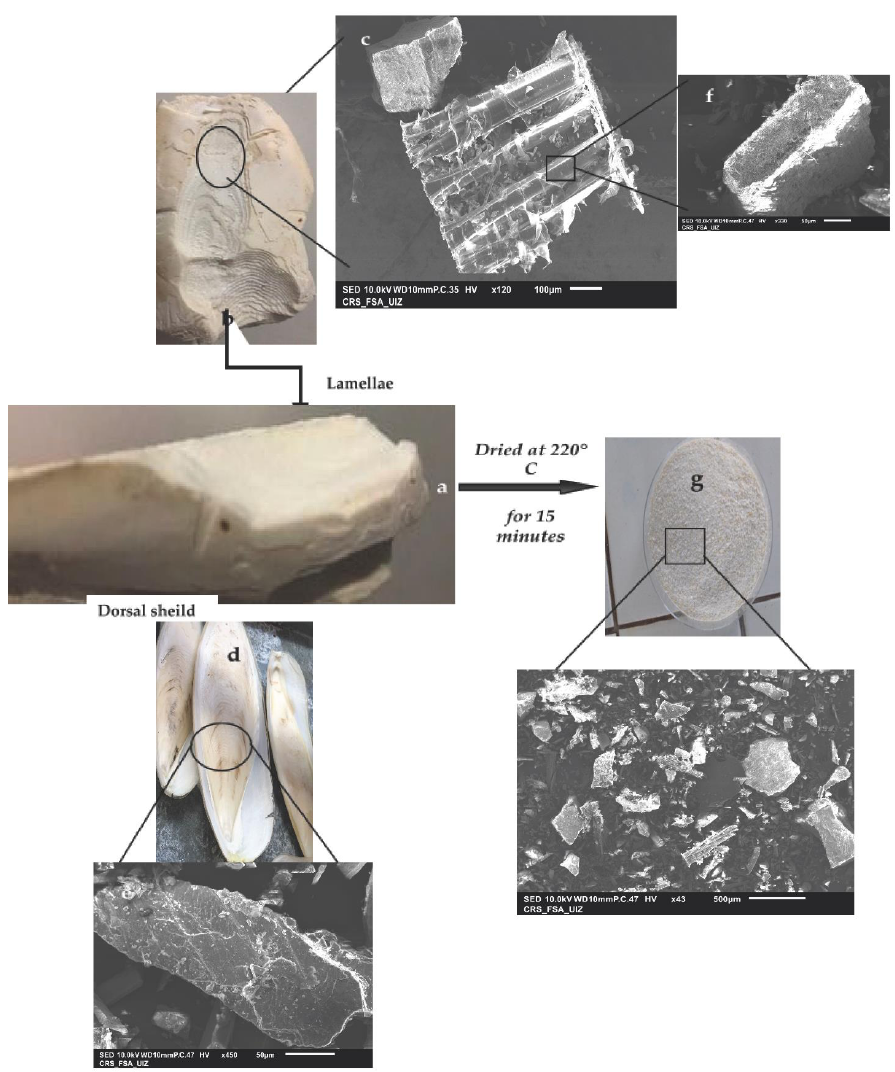
Figure 2. Enlarged detail of all parts of the CB using a Scanning Electron Microscope (SEM): ( a ) real photo of sepia officinalis bone, ( b ) real photo of sepia officinalis lamellae, ( c ) lamellae spacing analysis by SEM, ( d ) real photo of sepia officinalis dorsal shield; ( e ) a part of CB organic layer is shown, ( f ) enlarged detail of a lamellae analysis by SEM ( g ) global view of CB powder, ( h ) global view of CB powder by SEM.